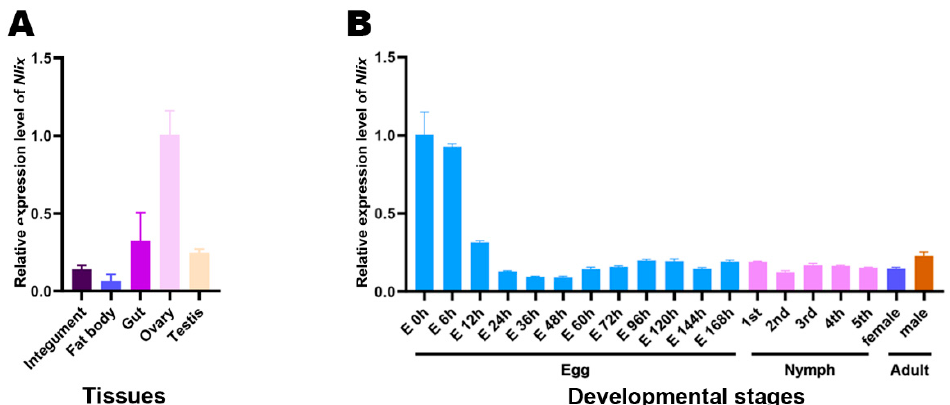
Figure 3. Temporal and spatial expression patterns of Nlix . ( A ) Tissue expression patterns of Nlix . Tissue samples were dissected from 50 adults 72 h after emergence, including integument, fat body, gut, ovary and testis. ( B ) Developmental stage expression pattern of Nlix . Total RNAs were extracted from whole insects at all life stages of BPH. Samples were collected every 24 h from the beginning of each stage. Nl18S was used to normalize the transcript level of Nlix for qPCR.